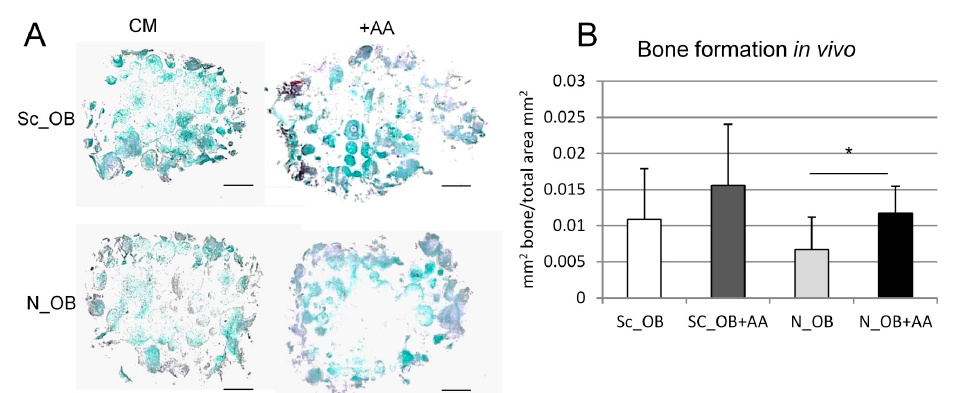
Figure 4. Effect of AA on OB differentiation. ( A ) Representative overview pictures of Masson trichrome-stained tissue of OB-seeded ceramic scaffolds (Engipore) implanted subcutaneously, taken 4 weeks after implantation; Scale bar = 1 mm; ( B ) Quantification of the corresponding bone-like areas, expressed as the ratio to the total area (mm 2 /mm 2 ) (mean ± SD of eight sections per experimental group); * indicates a statistically significant difference ( p <